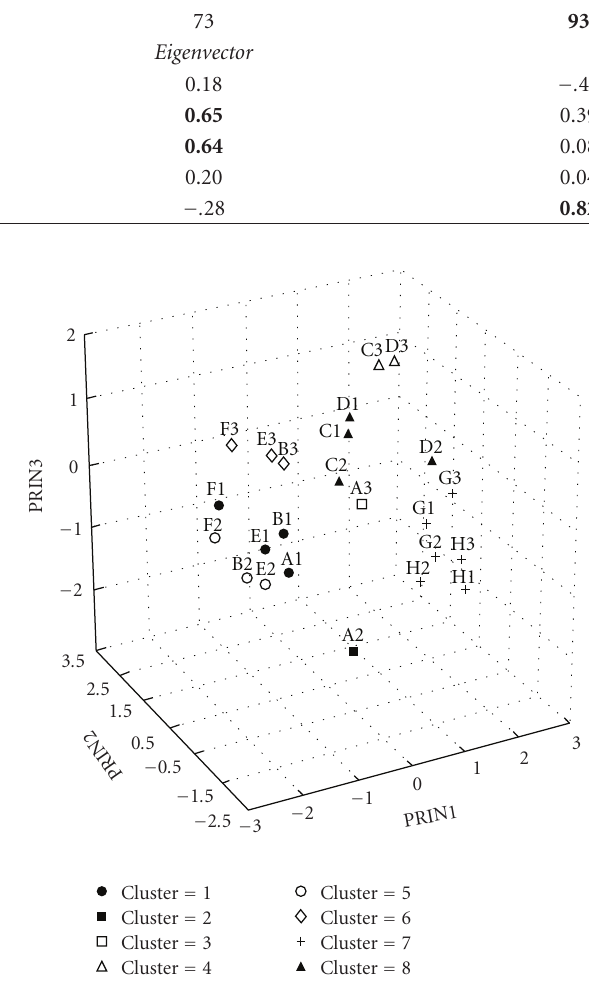
Figure 2: Rainfall and monthly temperatures during the growing